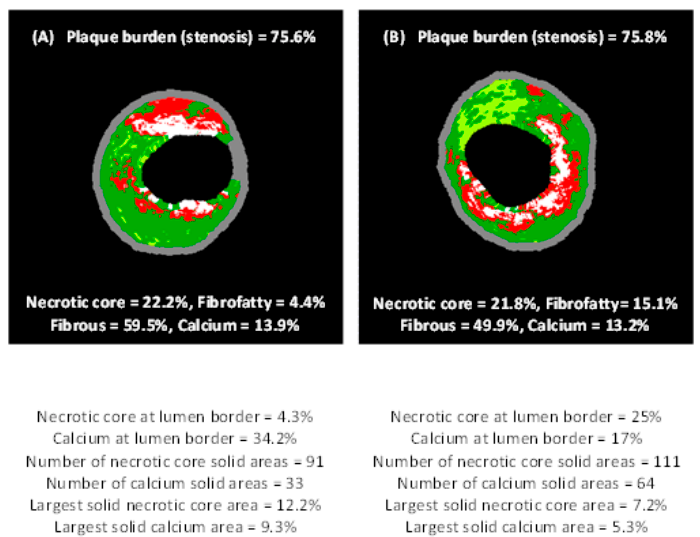
Figure 3. Two atherosclerotic plaques with similar percentages of stenosis, necrotic cores and calcium areas. Images were acquired through virtual histology–intravascular ultrasound imaging (VH–IVUS). ( A ) Plaque with less necrotic core and more calcium adjoined to the vessel lumen. A lower dispersity of necrotic core (NC) and calcium (C) is apparent. ( B ) In contrast to case ( A ), more necrotic core and less calcium are adjoined to the vessel lumen, whereas a greater dispersity of NC and C is apparent. Images were published by Papaioannou et al. [77].